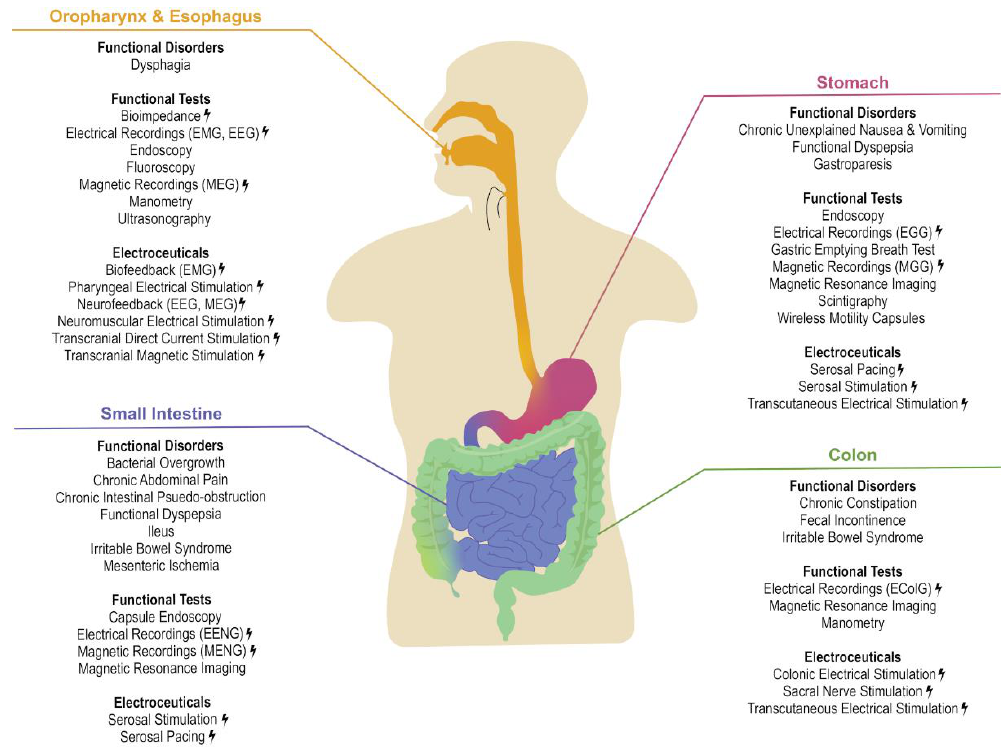
Figure 1. The overview of functional disorders within the gastrointestinal (GI) tract together with conventional motility tests and bioelectromagnetic diagnostic methods and therapies.